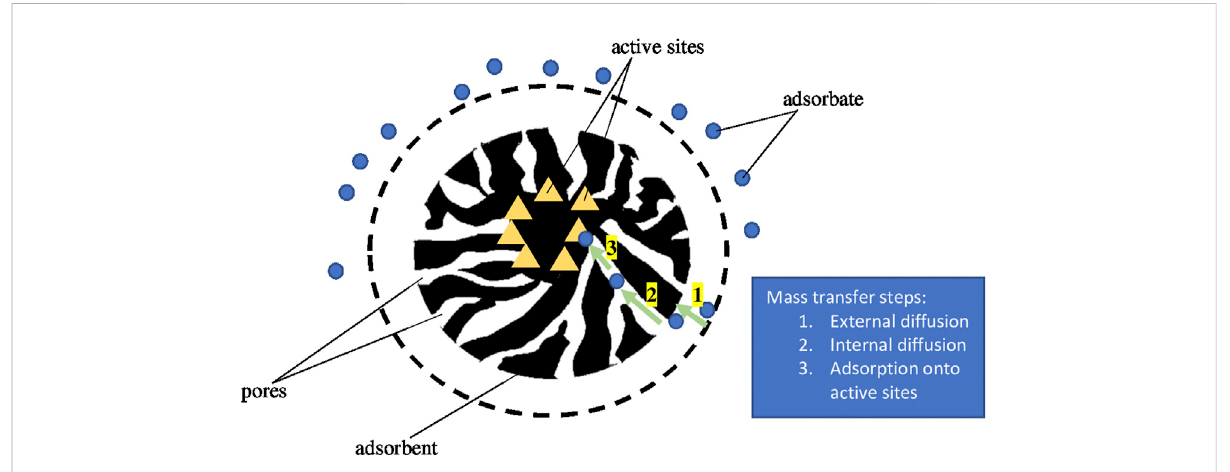
FIGURE 3 Mass transfer steps during the adsorption process